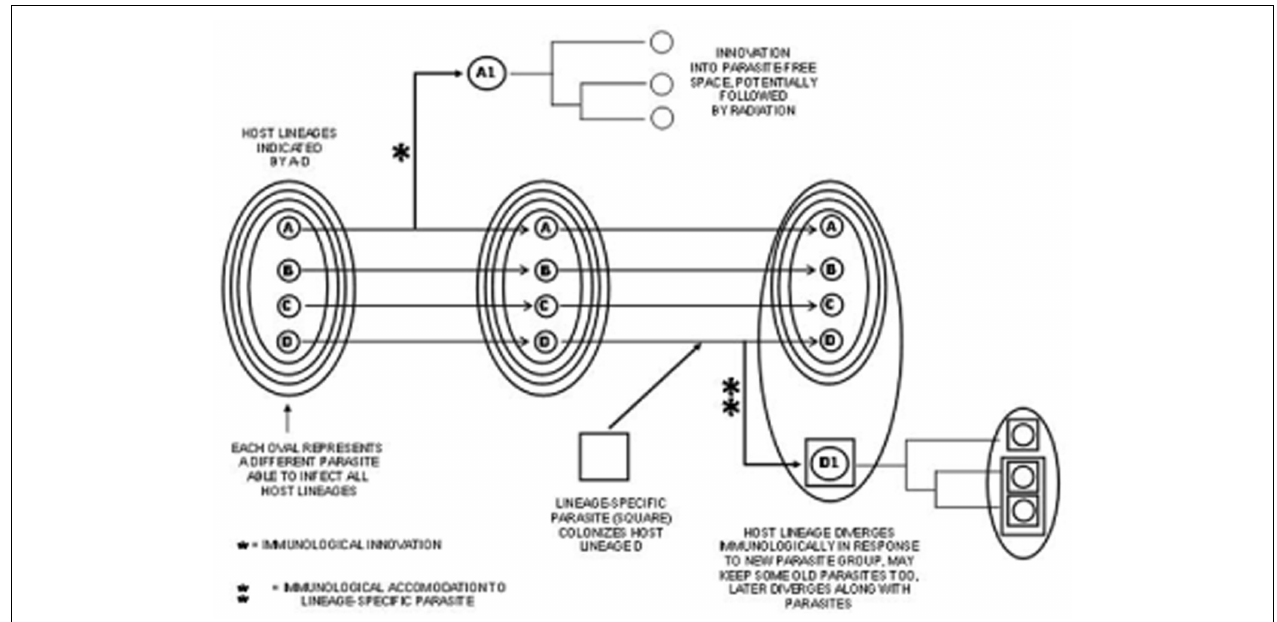
“parasite-free space” in this host lineage. At the bottom, lineage D has acquired a lineage-specific parasite different from those previously experienced.This requires an immunological accommodation that causes the immune system of lineage D1 to diverge. Both the host lineage and the lineage-specific parasites along with them may subsequently